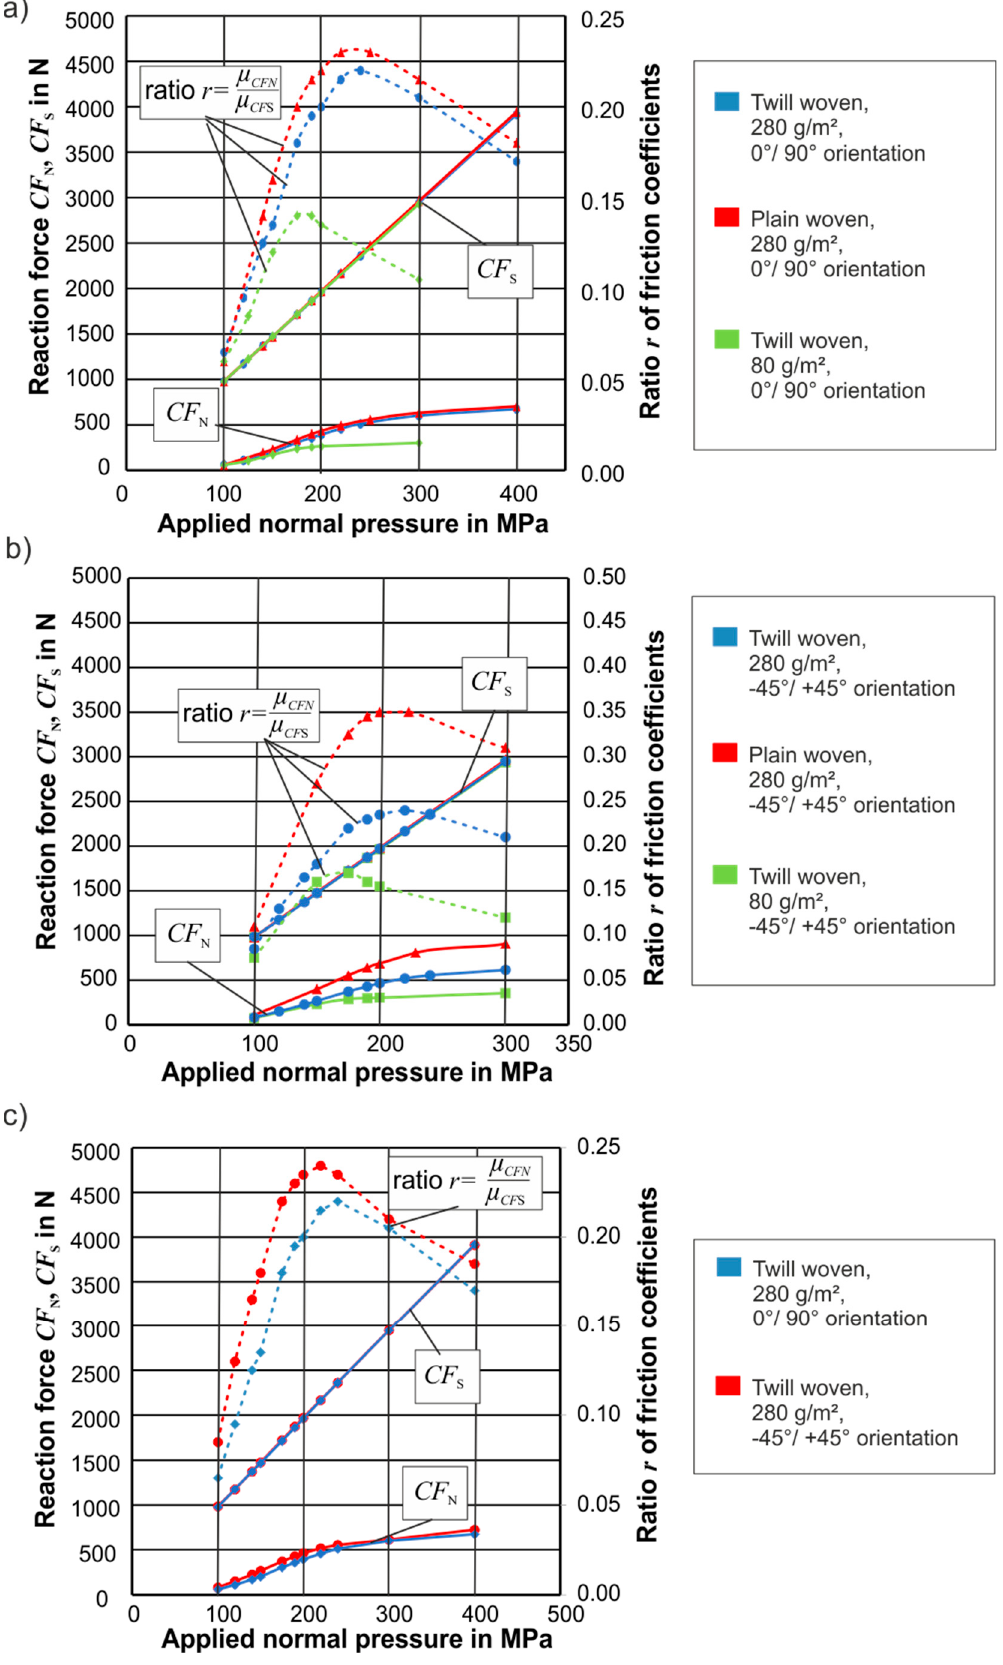
Figure 11. Numerical results of forces between sheet and fibers in tangential direction and friction coefficient at sticking state: ( a ) for 0°/90° orientation of fibers; ( b ) for − 45°/45° orientation of fibers; ( c ) comparison of both orientations.